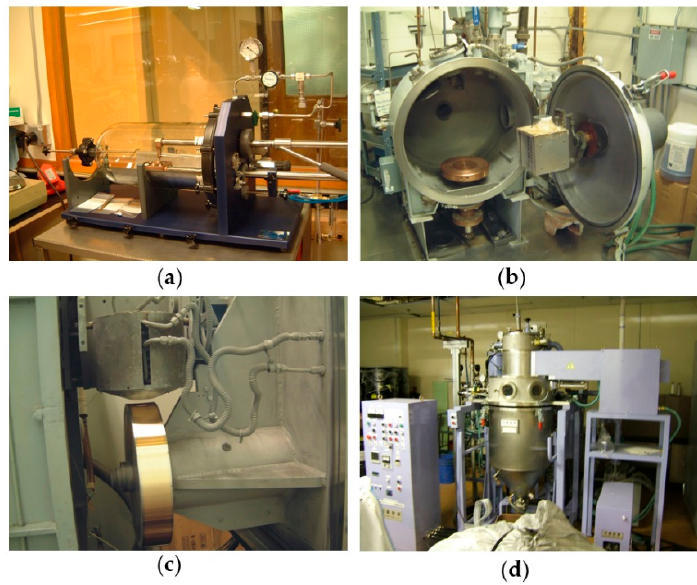
Figure 4. Images of ( a ) an arc melter, ( b ) a centrifugal casting VIM, ( c ) a melt-spinning VIM, and ( d ) a gas atomizer. The first three are operated in Ovonic-BASF and the fourth one is in Eutectix, Troy, MI, USA.